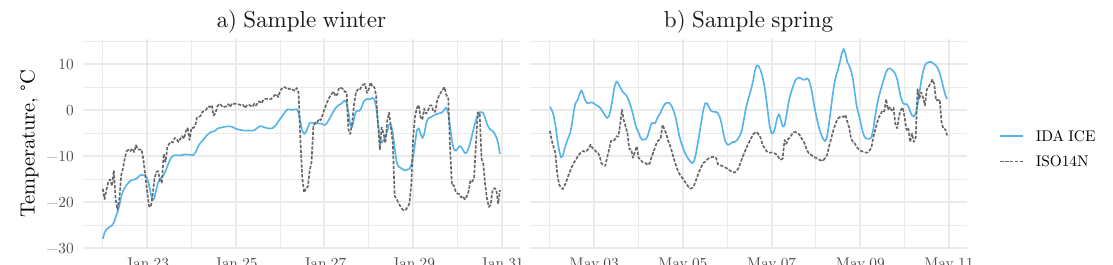
Figure 7. Comparison with IDA ICE on apparent sky temperatures for two sample periods. Solid blue line shows results from IDA ICE, gray dotted line shows from the ISO14N model.